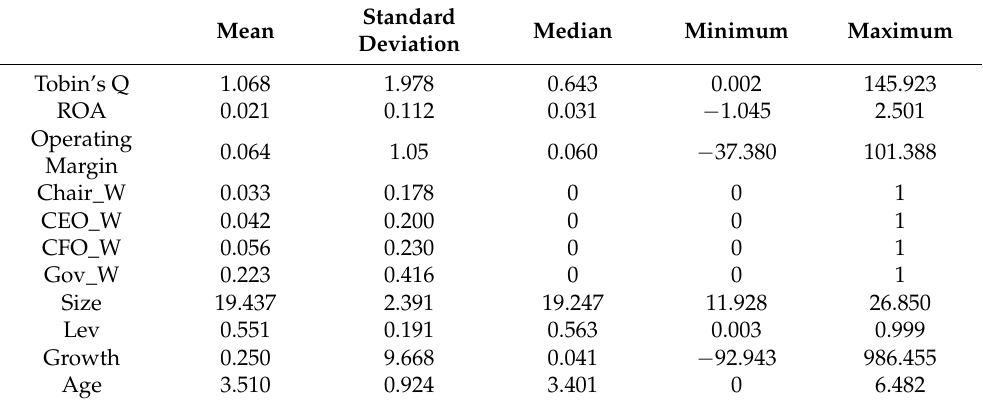
Table 3. Descriptive